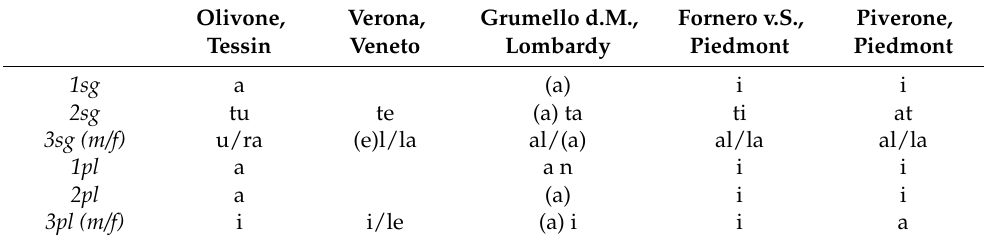
Table 2. Examples of paradigms of subject clitics in Italo-Romance